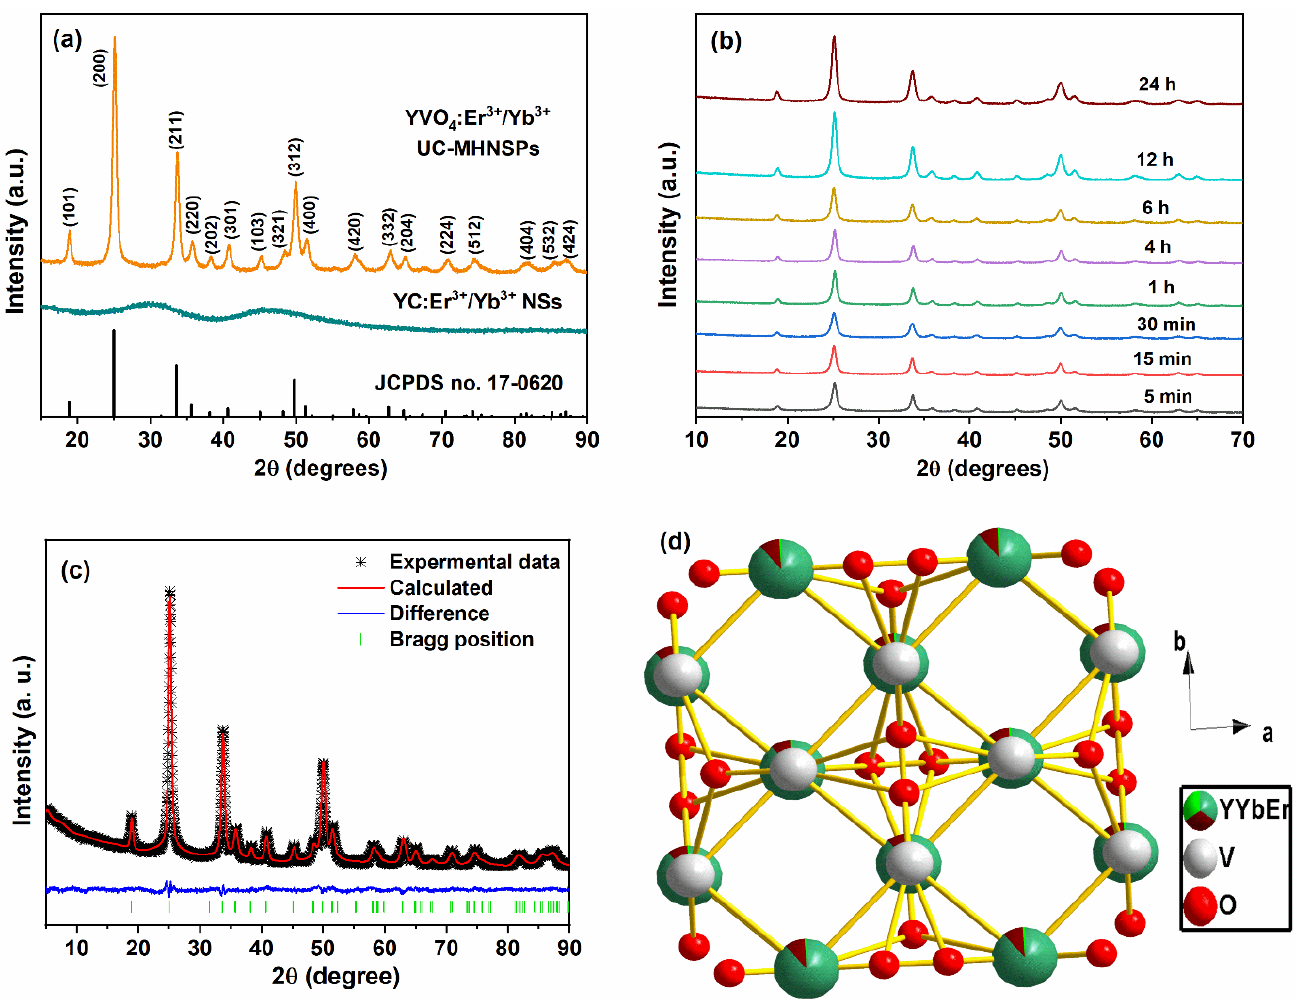
Figure 3. ( a ) XRD patterns of YC:Er 3+ /Yb 3+ NSs and YVO 4 :Er 3+ /Yb 3+ UC-MHNSPs, ( b ) diffraction patterns of YVO 4 :Er 3+ /Yb 3+ UC-MHNSPs at various reaction timings, ( c ) Rietveld fit and ( d ) ideal unit cell of YVO 4 :Er 3+ /Yb 3+ UC-MHNSPs. Zeta potential was measured to study the dispersion stability of the YC:Er 3+ /Yb 3+ NSs and YVO 4 :Er 3+ /Yb 3+ UC-MHNSPs in DI water and the acquired results are shown in Figure 4d. As expected, both the NSs and UC-MHNSPs exhibited positive surface charge of 15.29 and 31.99 mV, respectively. Because YC:Er 3+ /Yb 3+ NSs were synthesized by the well- known UHP method (where urea (CO(NH) 2 ) produces NH 4+ ions) and for the synthesis of YVO 4 :Er 3+ /Yb 3+ UC-MHNSPs, NH 4 VO 3 was taken as vanadium source and NH 4 F was used as flux. Thus, the excess of NH 4+ ions present in the solvent causes the positive charge density on the surface of the UC-MHNSPs. Typically, the nanoparticles with Zeta potential lower than − 30 mV or higher than +30 mV are considered as highly dispersible and are suitable for biomedical applications. Hence, our synthesized YVO 4 :Er 3+ /Yb 3+ UC-MHNSPs with 31.99 mV Zeta potential can be used as an efficient drug carrier for biomedical